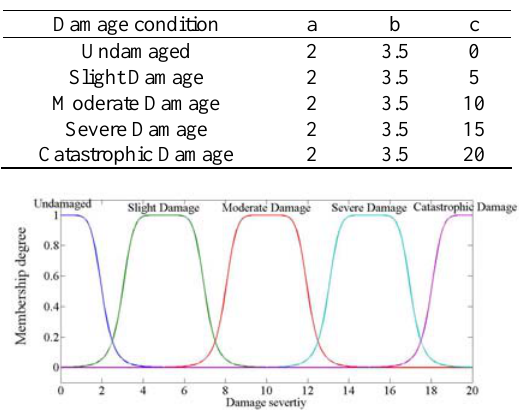
Fig. 8. Schematic diagram of membership function of outputs